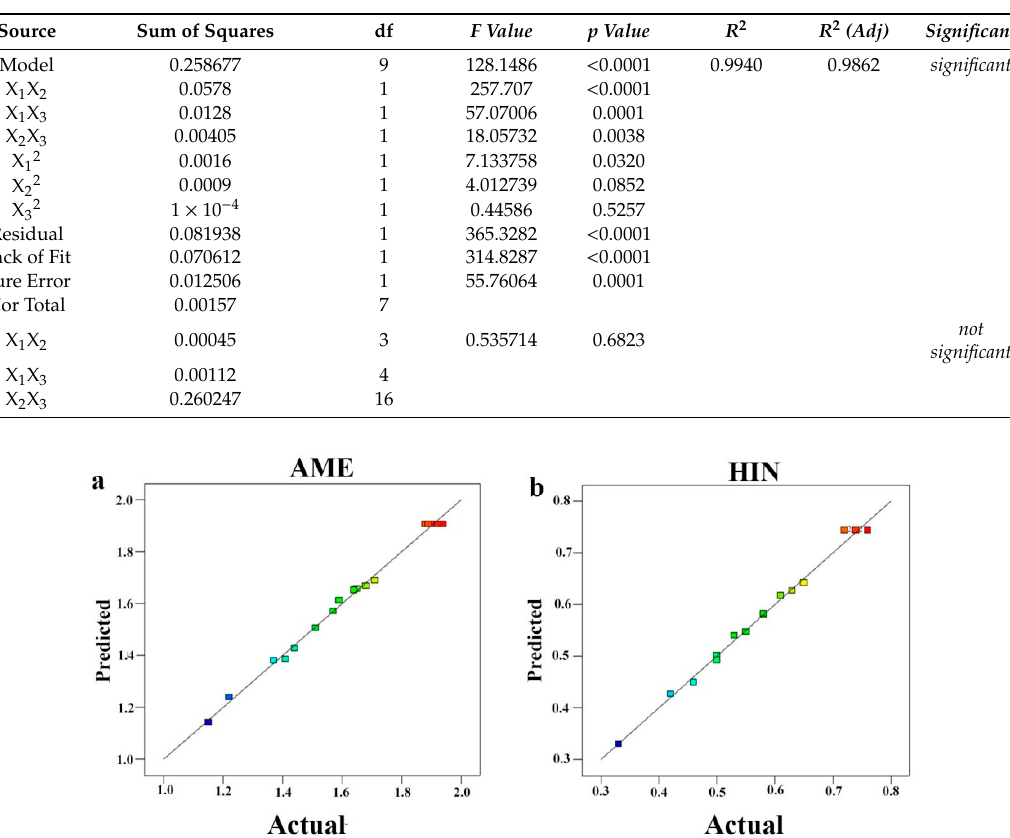
16 Table 2. ANOVA for the fitted secondary order curve for HIN content. Source